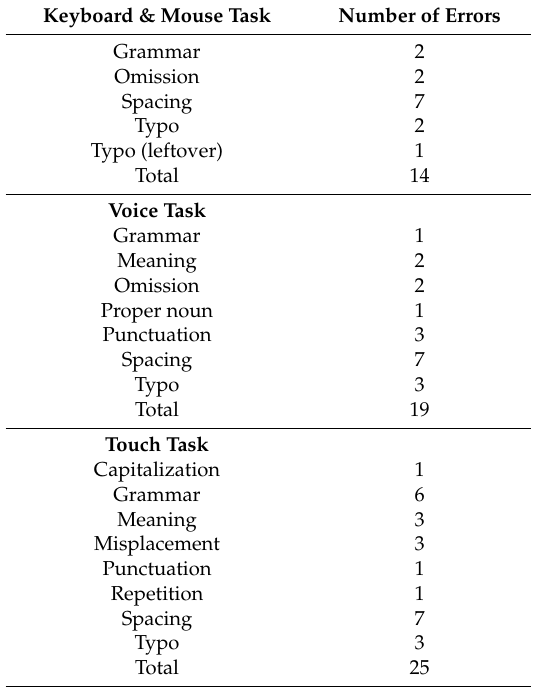
Table 1. Types of errors encountered in the final translations, according to the type of